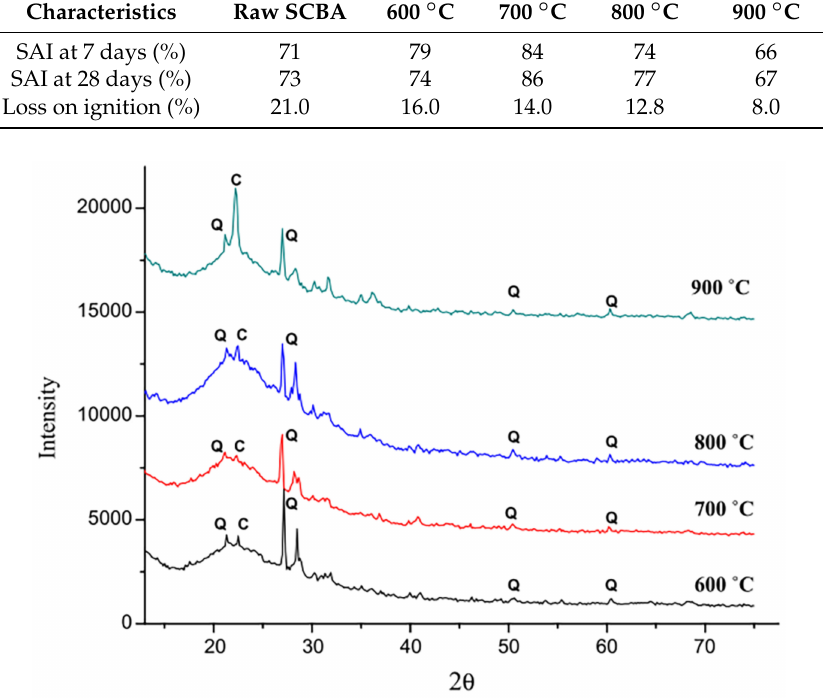
Figure 6. X-ray diffraction pattern of the burnt SCBA samples (Q: quartz, C: cristobalite). Reproduced with permission from